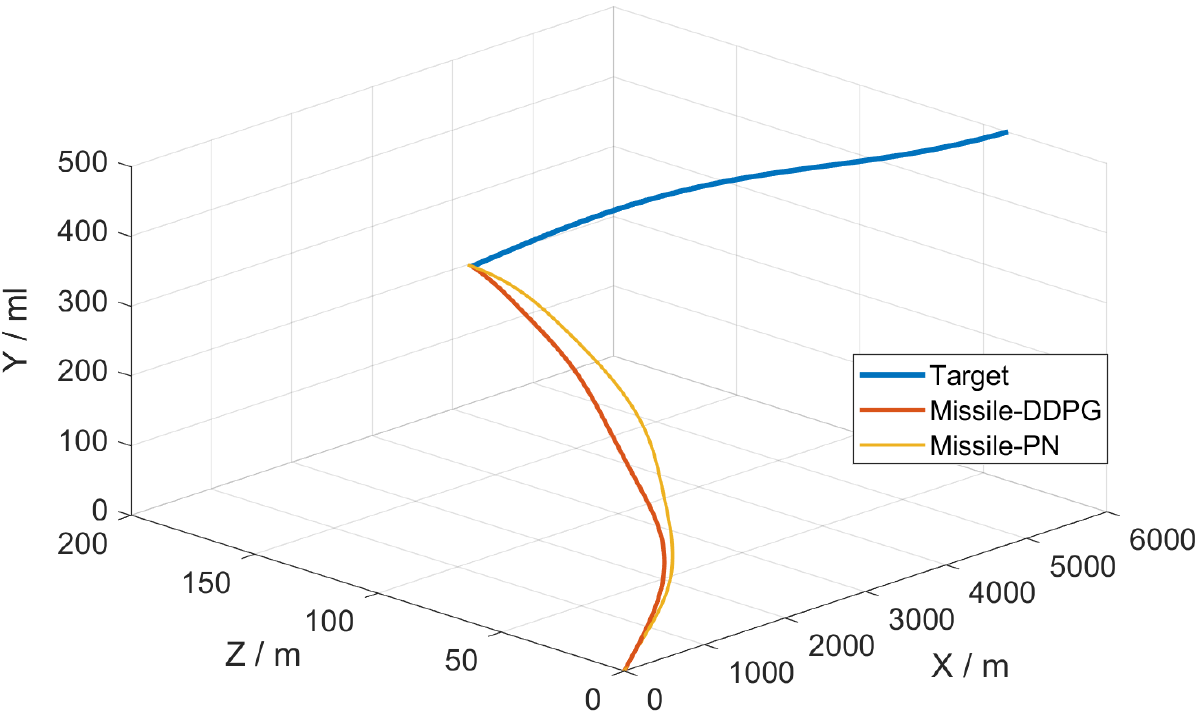
Figure 6. Missile – target 3D trajectory diagram (Scenario